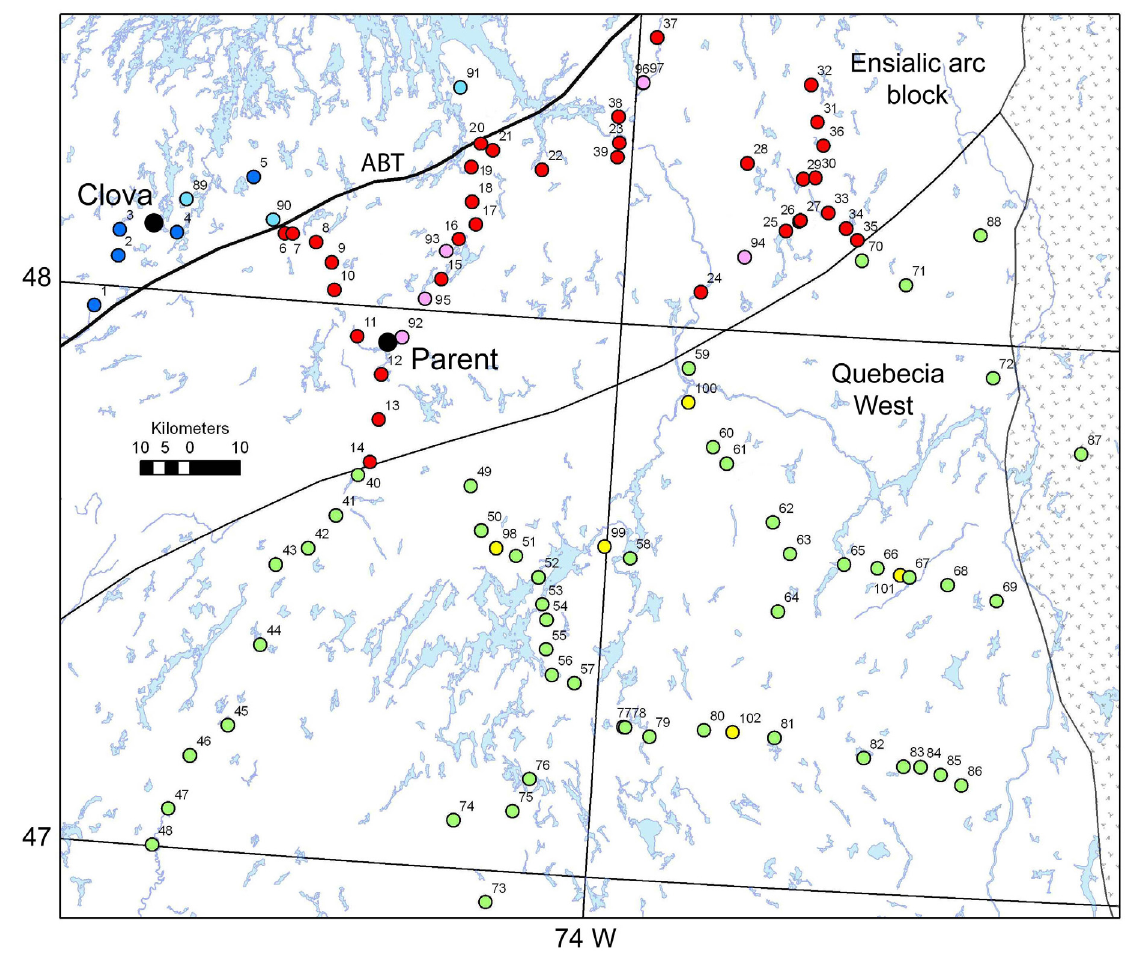
Figure 3. Sample locations within the Parent-Clova region, Quebec. Dark and pale blue = ages, respectively, above and below 2.4 Ga in the Archean Parautochthon; red and pink = ages, respectively, above and below 1.64 Ga in the Ensialic Arc block; yellow and green = ages, respectively, above and below 1.64 Ga in the western extension of